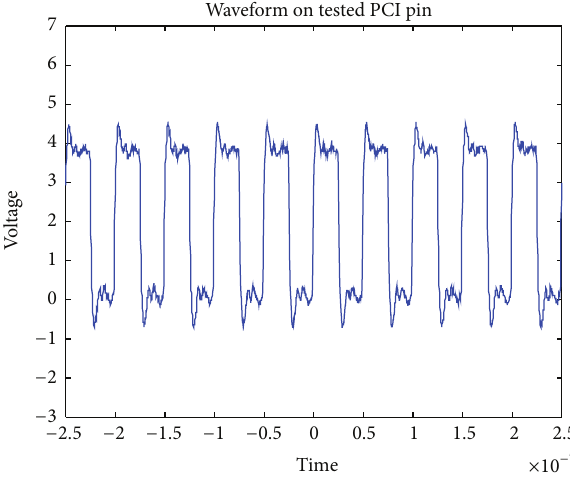
Figure 15: No. 3 SI test on PCI